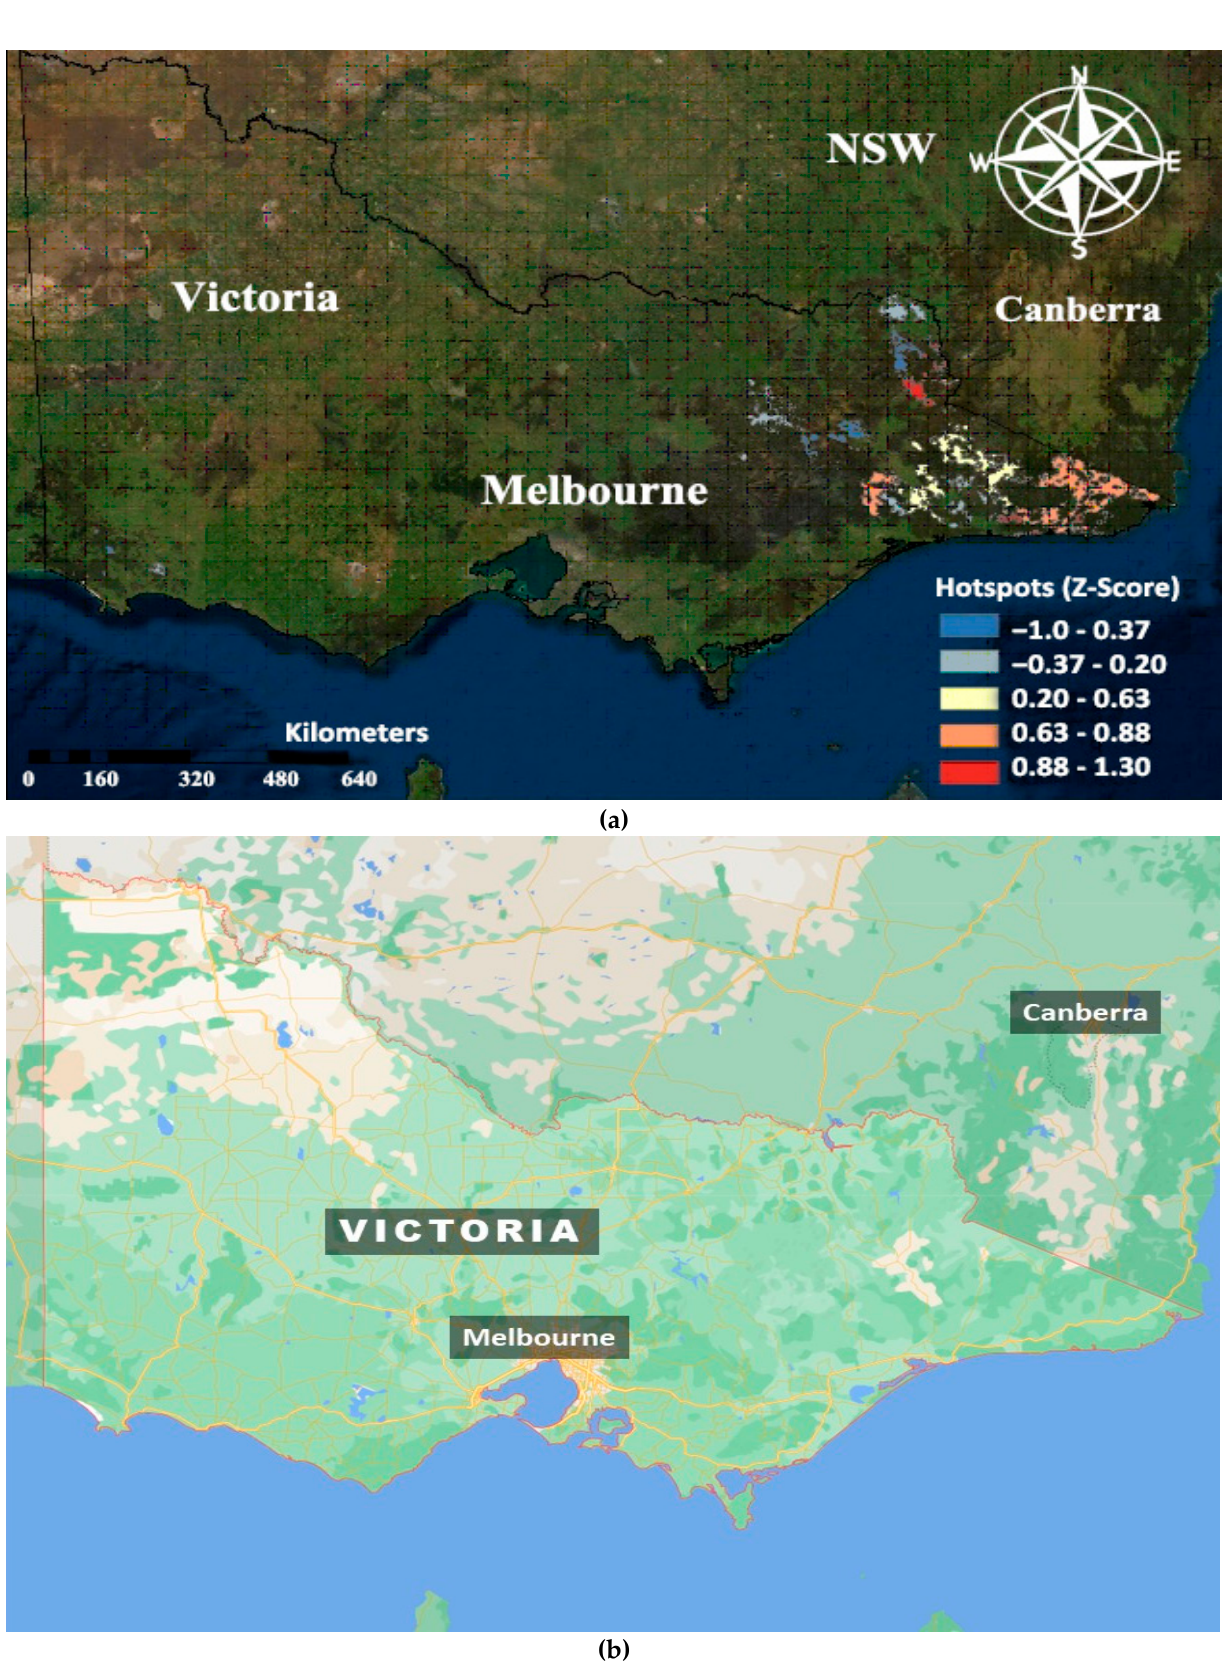
Figure 13. Bushfire’s hotspot mapping and direction of flow ( a ) Value-based Hotspots and Coldspots of Victoria, ( b ) Directional Flow of the Victorian Bush Fires.